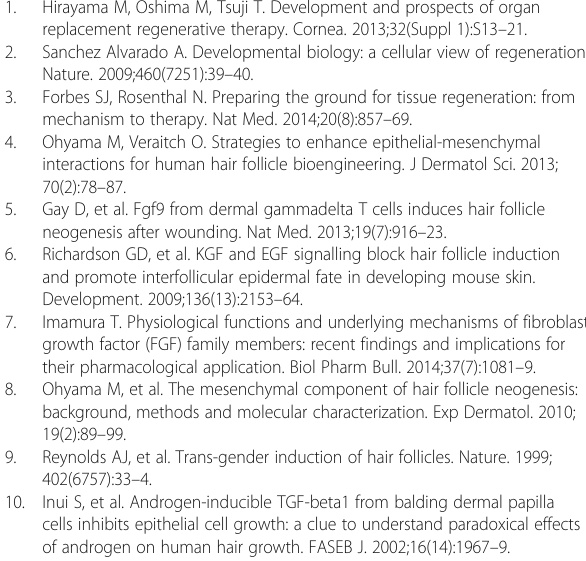
Additional file 1. Supplementary Table 1. Sequence of primers used for RT-PCR. Supplementary Table 2. Sequence of primers used for quantitative RT-PCR are